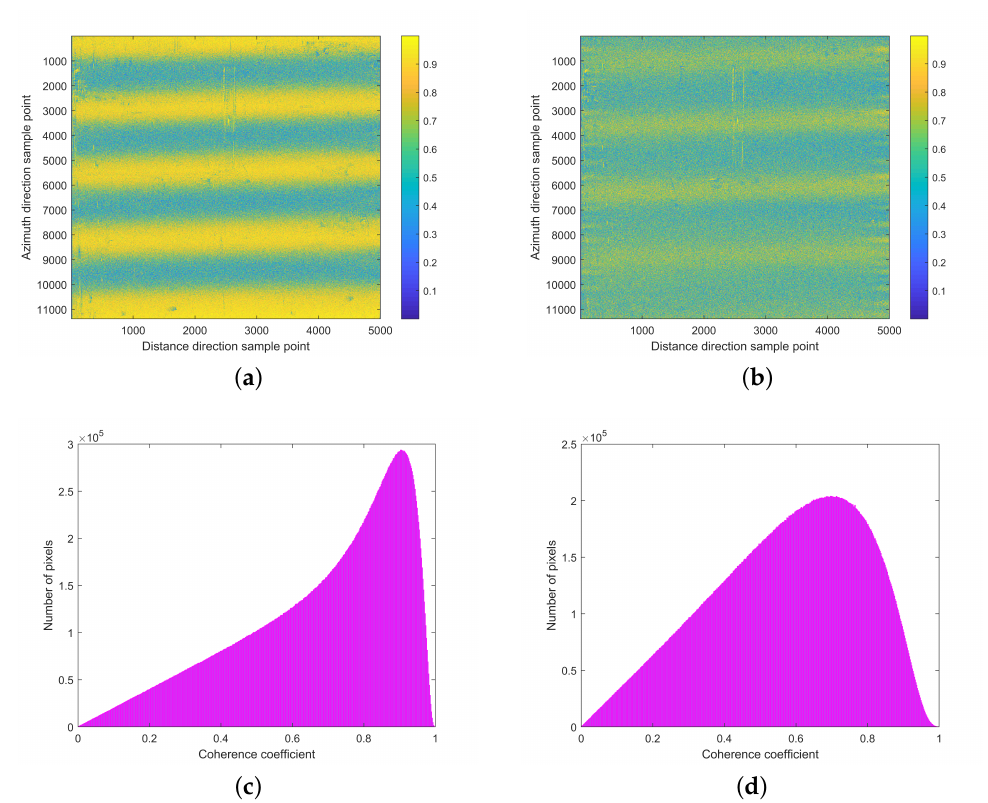
Figure 16. The comparison results. ( a ) The main POS imaging coherence coefficient diagram; ( b ) the left POS imaging coherence coefficient diagram; ( c ) the main POS imaging coherence coefficient statistical histogram; ( d ) the left POS imaging coherence coefficient statistical histogram.